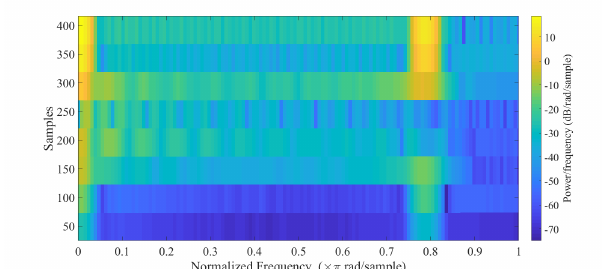
Figure 9. Frequency analysis of the red-to-red link.